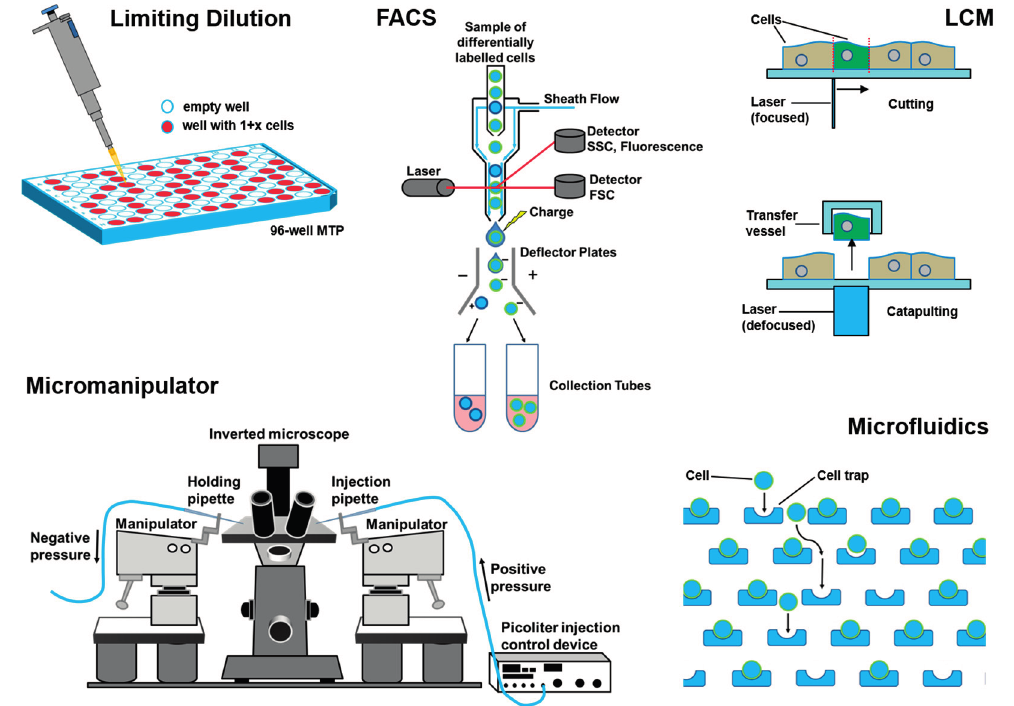
Figure 3. Schematic overview of single-cell separation technologies discussed in the